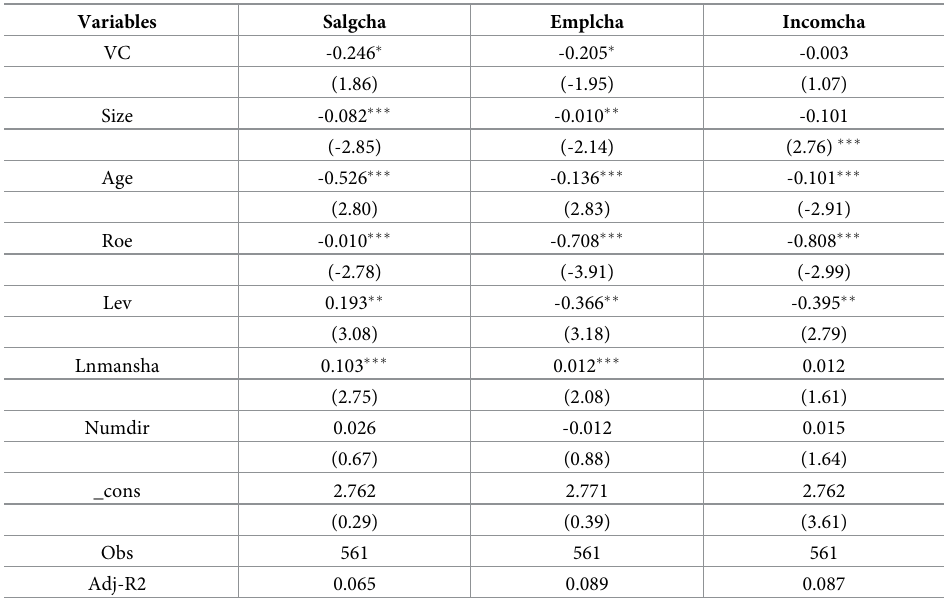
Table 6. Regression after score